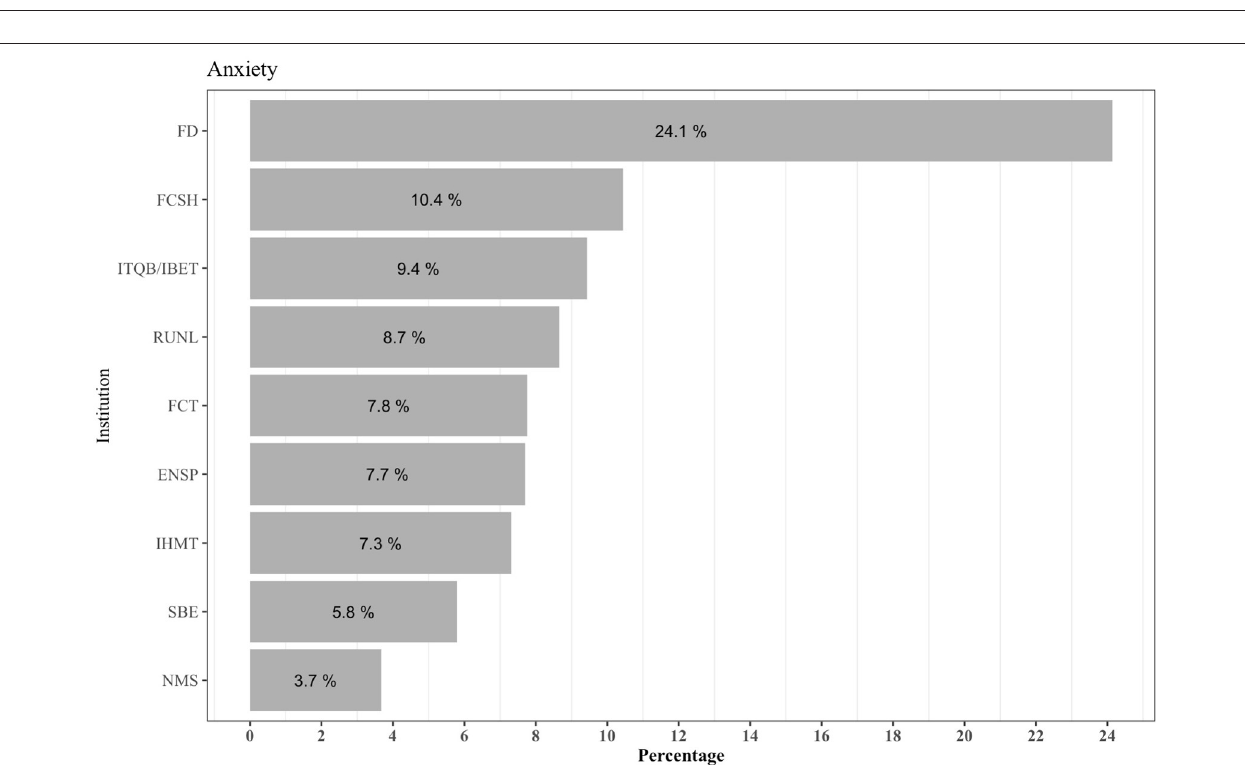
FIGURE 3 | Prevalence of anxiety symptoms based on the number of individuals per organic unit ( n = 117).